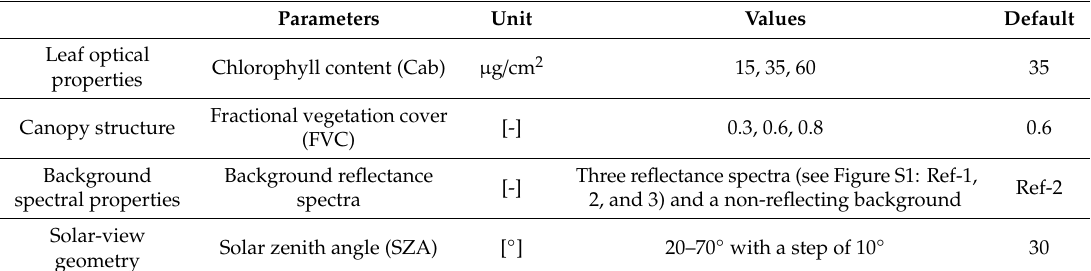
Table 2. Main input parameters of the Discrete Anisotropic Radiative Transfer (DART) simulations with indication of the default